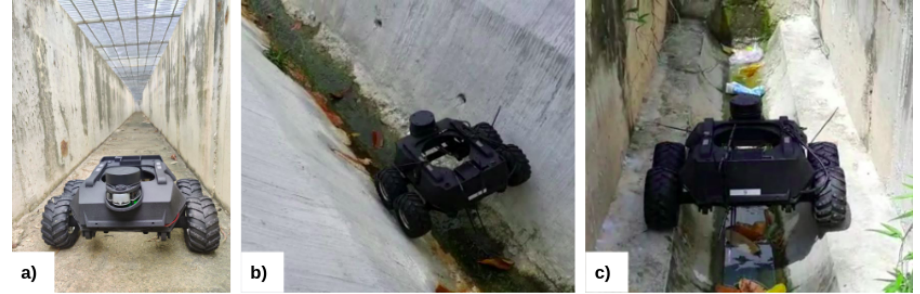
Figure 3. Adaptability of the robot to various drain scenarios. ( a ) In a drain with a flat floor ( b ) In a drain with a curved bottom ( c ) In a cut-off drain